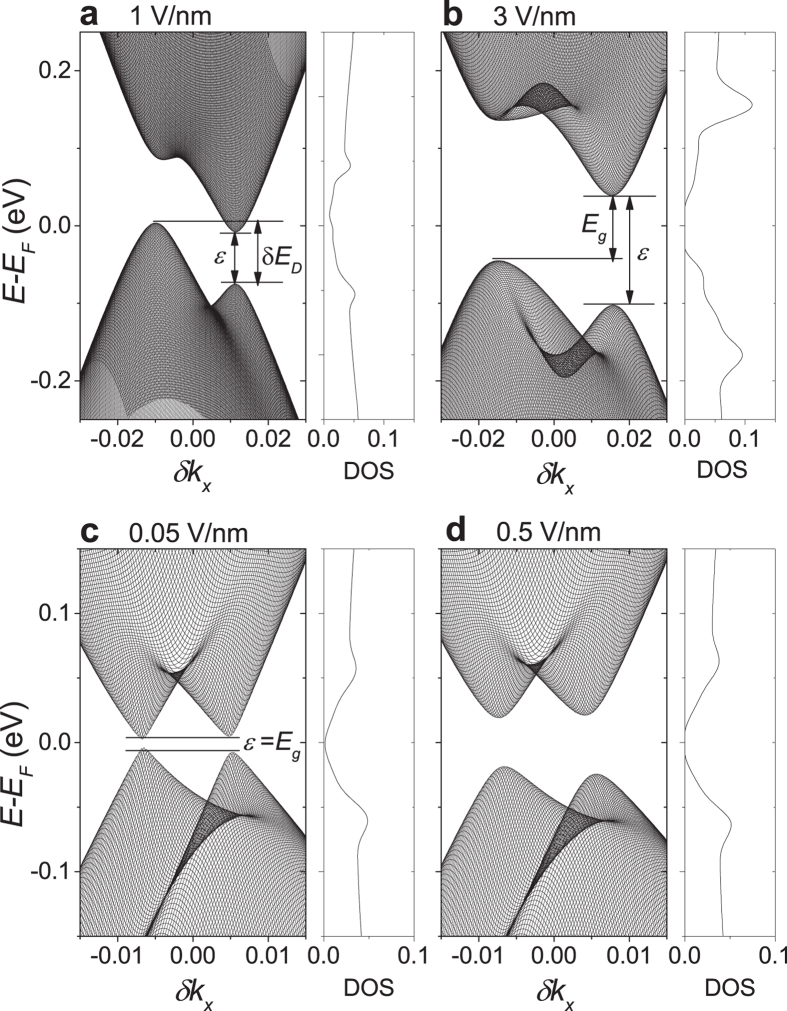
Band structure and density of states near the  point.In each panel, the band structure and density of states (DOS) are shown on the left and right, respectively. The Fermi level  was set to zero. Panels (a,b) correspond to Fz = 1 and 3 V/nm, respectively, when ds = +0.24 . Panels (c,d) correspond to Fz = 0.05 and 0.5 V/nm, respectively, when ds = −0.24 . DOS was shown in arbitrary units and  =  = 1000 in units of 2/. When ds > 0, as shown in panels (a,b), the electric field-induced energy gap  at the Dirac points must exceed the Dirac energy difference  in order to open a band gap . When ds < 0, as shown in panels (c,d),  is equal to .